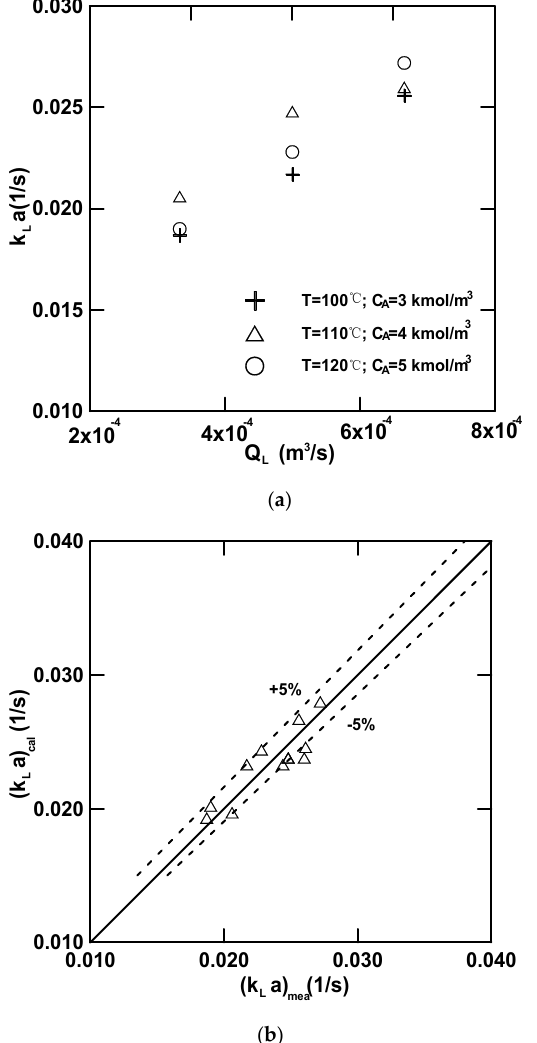
Figure 6. Effects of variables on mass transfer coefficient. ( a ) Effect of liquid flow rate on the kLa, ( b ) a plot of (kLa)emp versus (kLa)model.